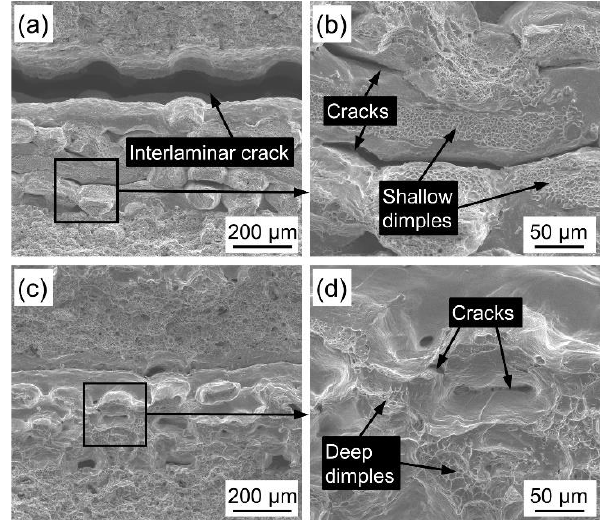
Figure 9. Impact fractures morphology of PWMCPPs with different sintering temperatures. ( a ) Lower magnification and ( b ) higher magnification of the PWMCPP with 1160 °C sintering temperature; ( c ) lower magnification and ( d ) higher magnification of the PWMCPP of 1360 °C sintering temperature.